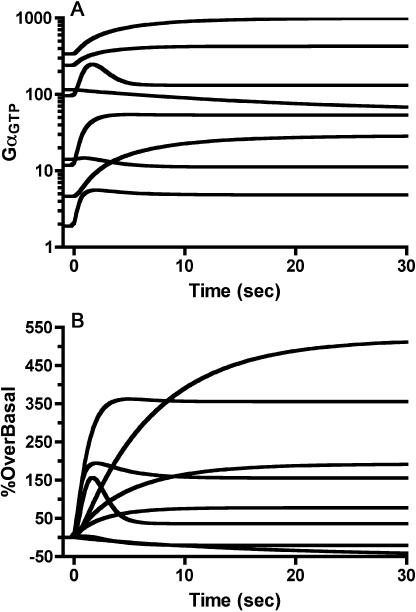
Time Course of Representative Model OutputsParameter values are sampled using LHS, and the differential equations describing the cTCAM are solved according to the equations in Text S1. G protein activation as quantified by GαGTP is tracked over time (see Equation S.27 in Text S1).(A) Values of GαGTP (number/cell) for eight parameter sets from LHS sampling of the ranges in Table 1 are plotted over the course of the simulation.(B) Percent change in the value of GαGTP relative to basal values (%OverBasal) was calculated and tracked over time according to Equation 1. [L] = 0.1 μM.